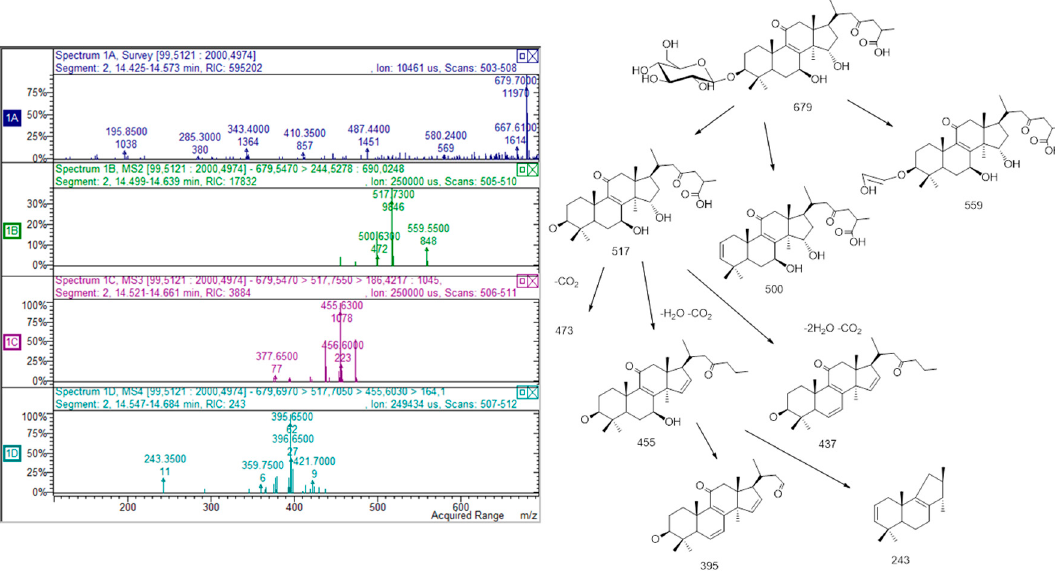
Figure 3. Proposed fragmentation scheme and MS n spectrum of derivative m / z 679, tentatively assigned to a glycosidic derivative of ganoderic acid.